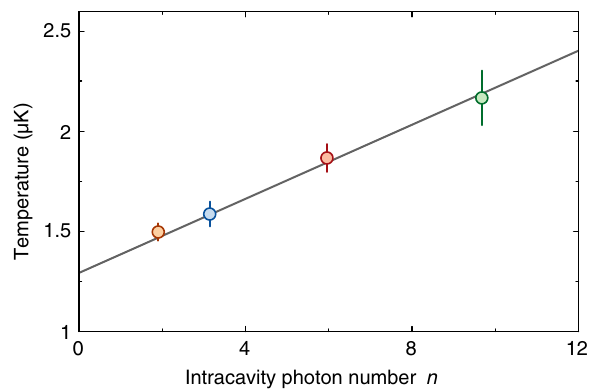
FIG. 6. Temperature after evaporation. Temperature of the gas measured in time of flight after the final swept atom-number measurement for different intracavity photon numbers. The gray line is a linear fit guiding the